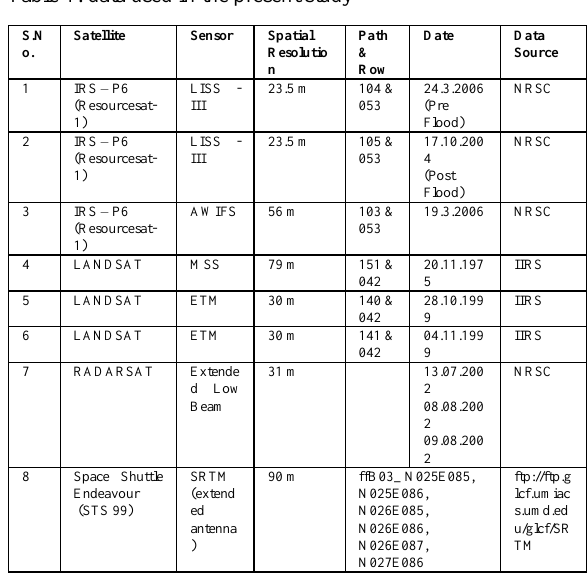
Table 1: data used in the present study